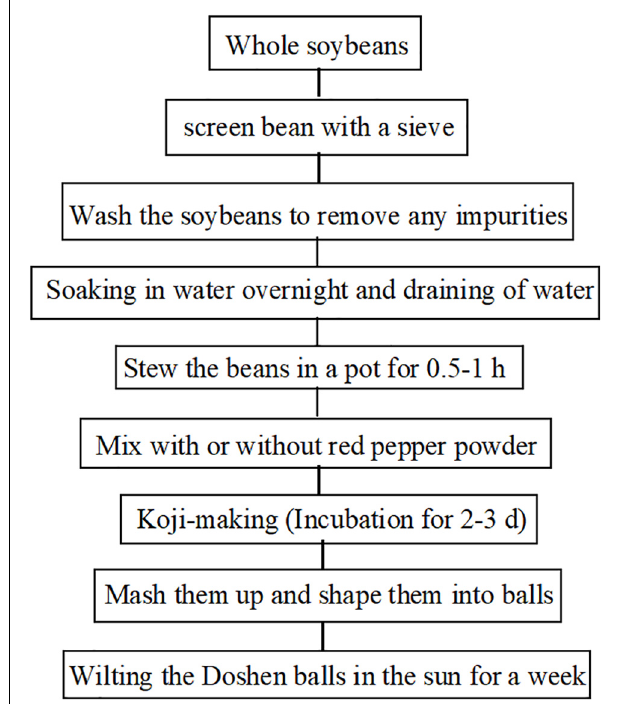
FIGURE 1 | A schematic diagram of the production of